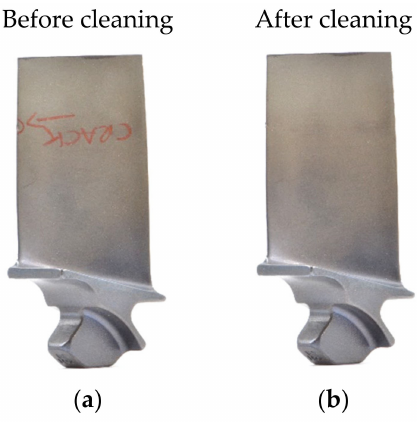
Figure 2. ( a ) Part before and ( b ) after marking